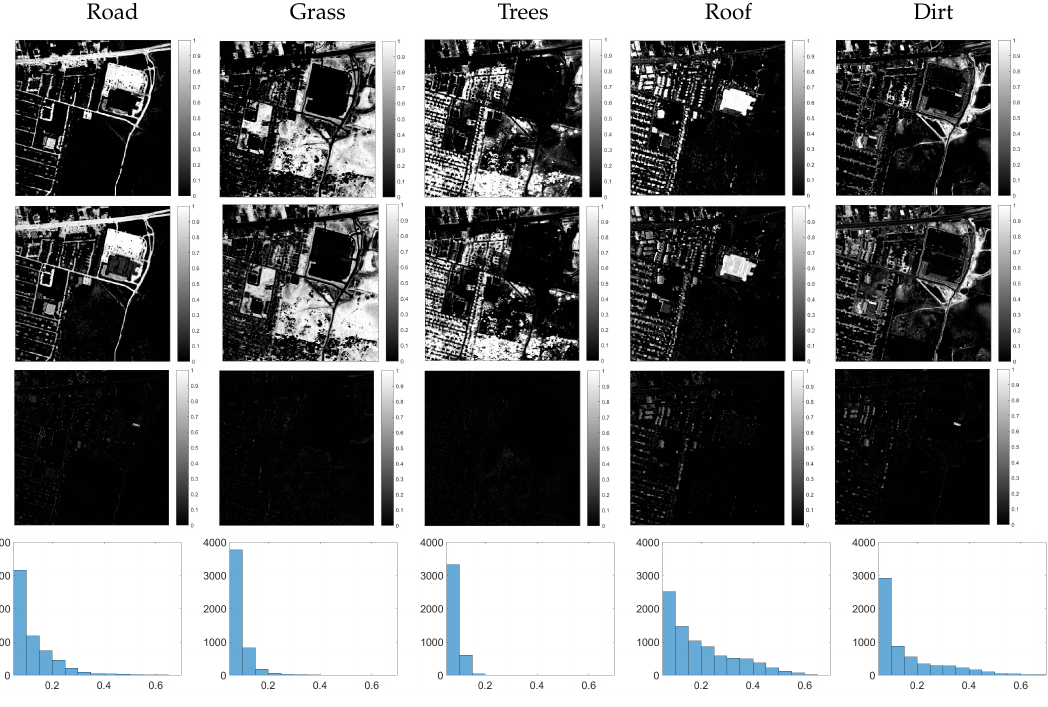
Figure 17. Comparison between abundance maps for information classes extracted using the proposed method and reference data. The top row shows the results of the proposed method. The second row shows the reference data. The third row shows absolute errors images. The bottom row shows the histograms for the error images.